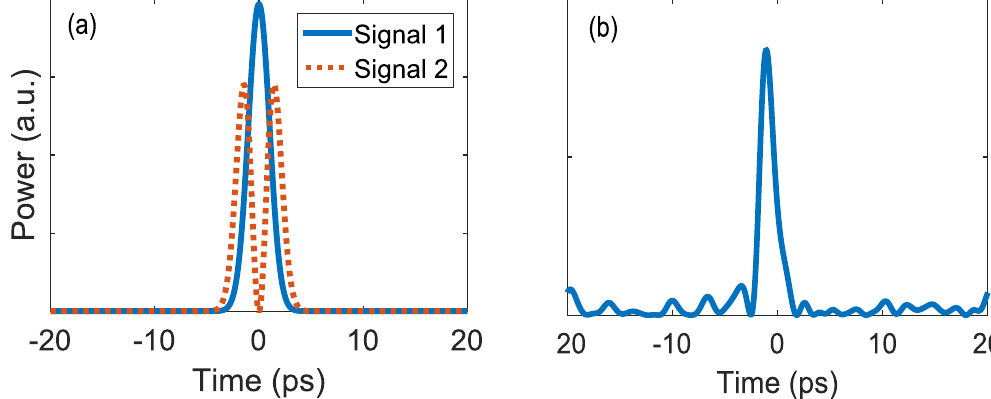
Figure 6. Distingushing TF filter’s modes. ( a ) shows the temporal profiles of the first two modes of a Guassian TF filter, where the pulse width of Signal 1 is 2 ps. ( b ) shows the pump pulse which is optimized to selectively convert Signal 1.